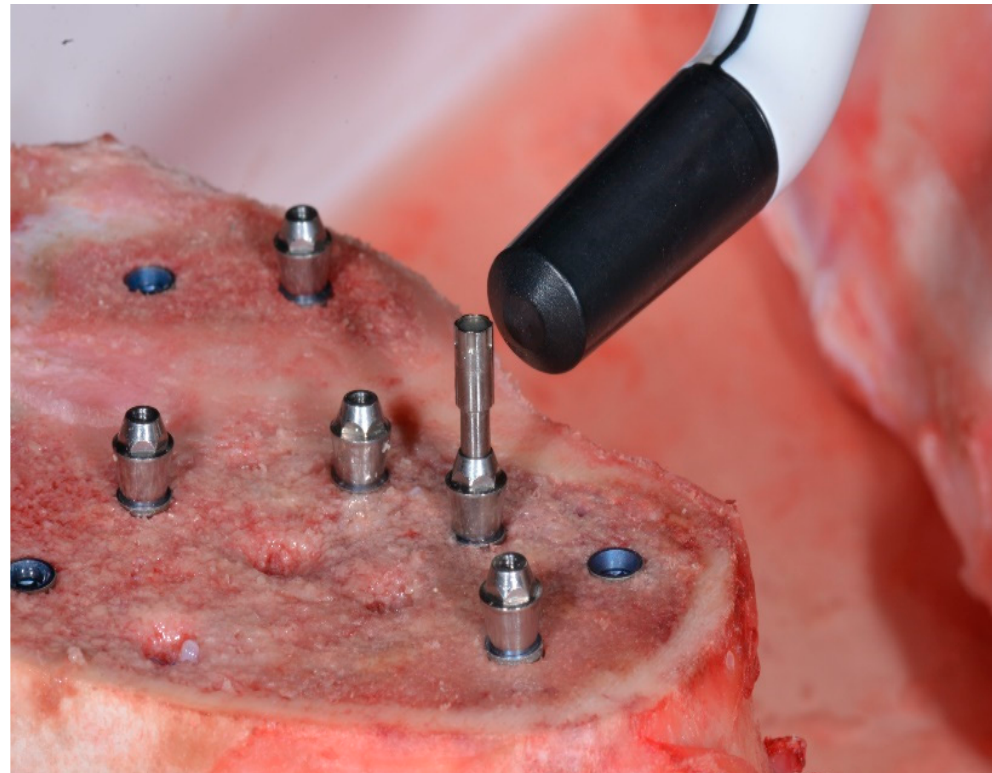
Figure 2. Resonance frequency analysis with Penguin RFA of Multipeg ® Reference 72 for the Permanent ® , straight abutment with a 2 mm height for Vega ® with a 4 mm diameter).